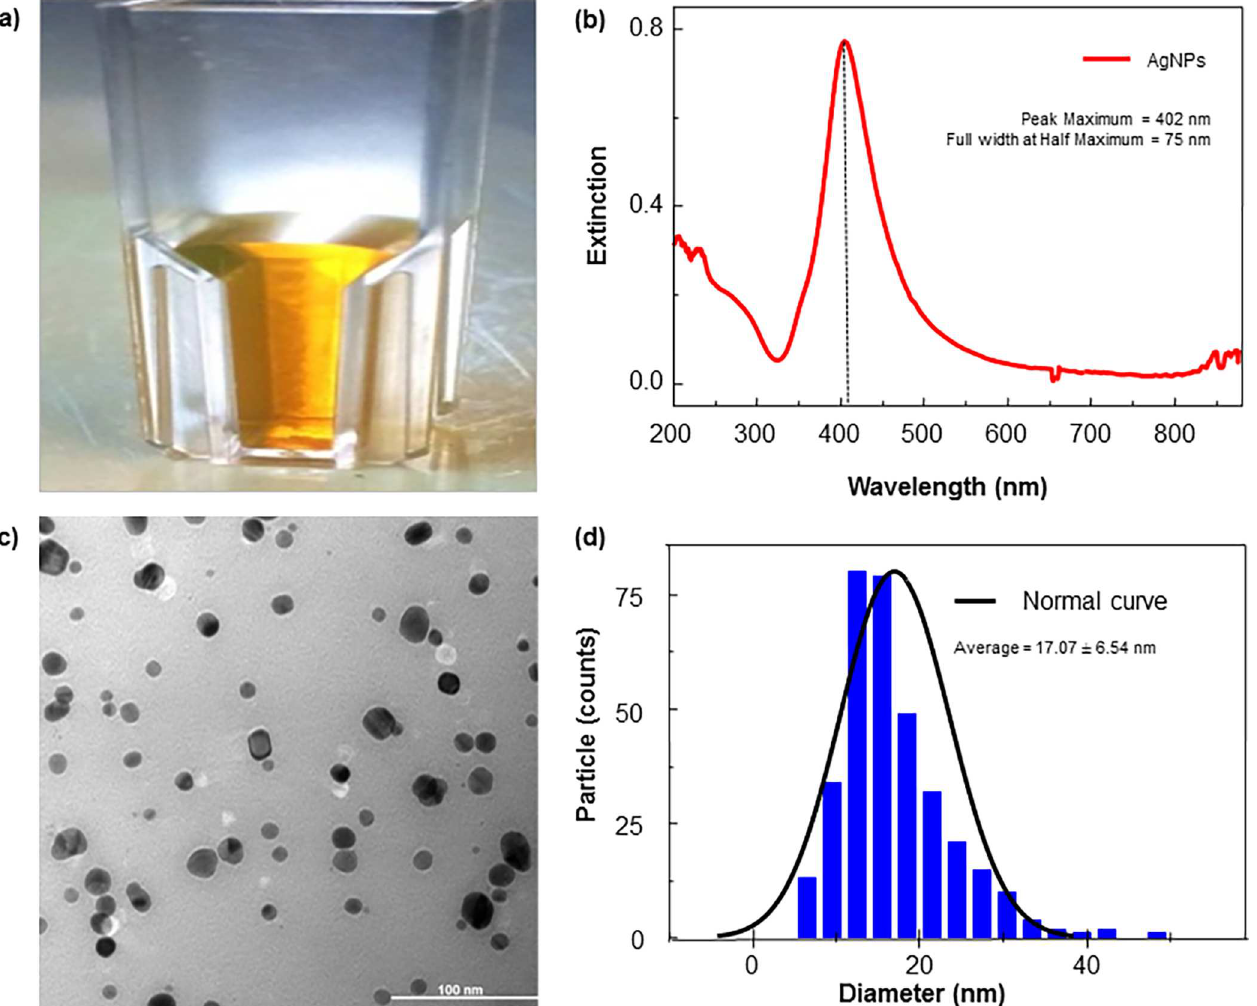
Fig 1. Characterization of AgNPs produced by chemical synthesis. (a) AgNP solution,(b) UV–vis absorption spectrum of AgNPs (b), TEM image of sphericalAgNPs (c), particle size distributions by Image J software (d). doi:10.1371/journal.pone.0168098.g001 PLOS ONE | DOI:10.1371/journal.pone.0168098 December15,